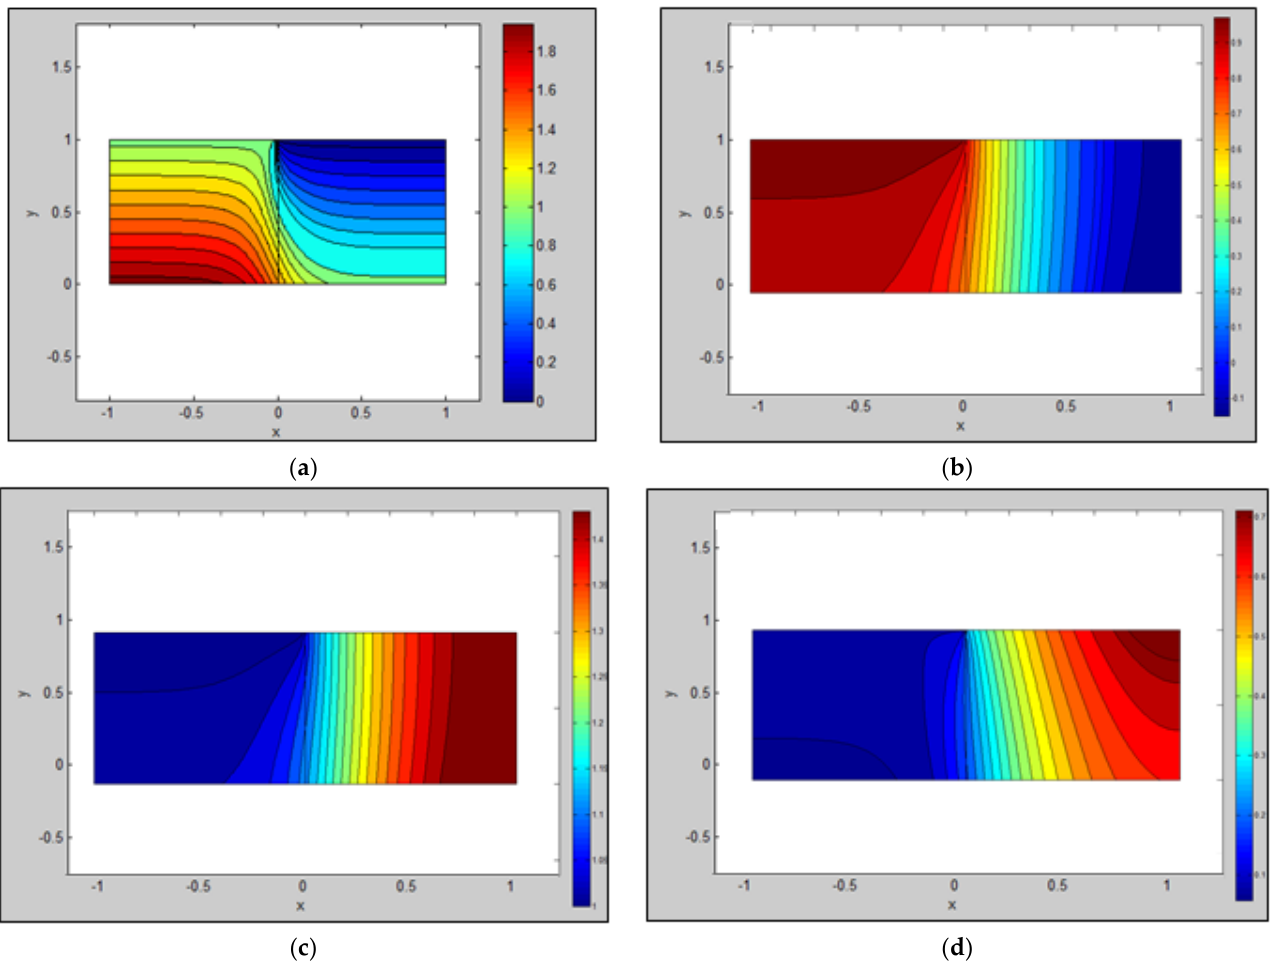
Figure 3. ( a ) Two-dimensional contour plot of temperature, ( b ) oxygen concentration, ( c ) 2D plot of water vapor concentration, ( d ) contour plot of saturation (adapted from [25]).